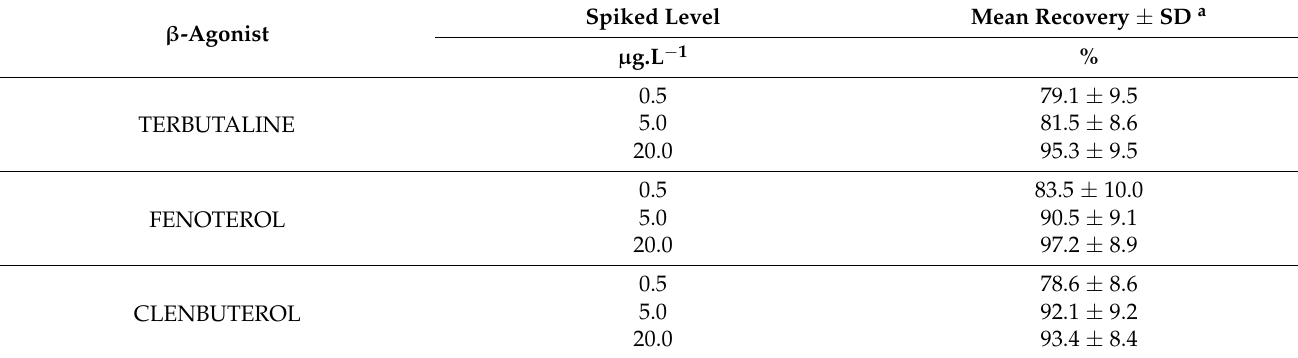
Table 4. Recoveries from urine calf samples spiked with β -Agonists at three different